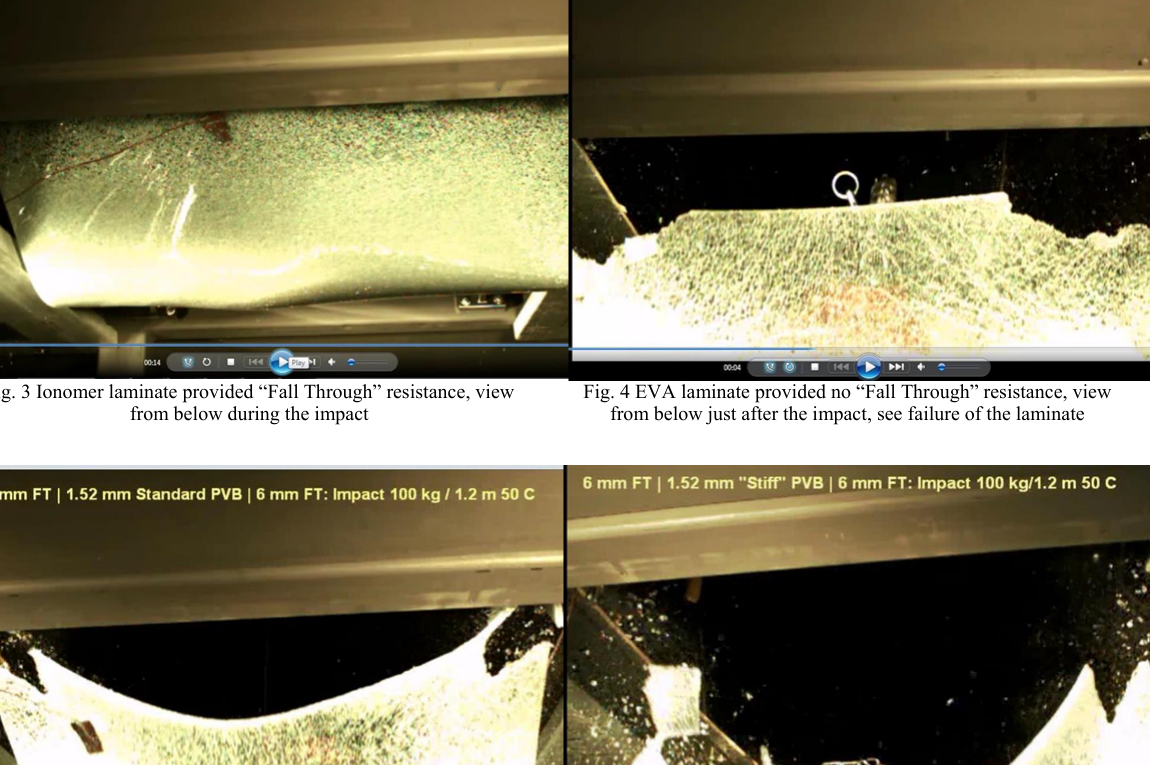
Fig. 6 Stiff PVB laminate provided no “Fall Through” resistance view from below just after the impact, see failure of the